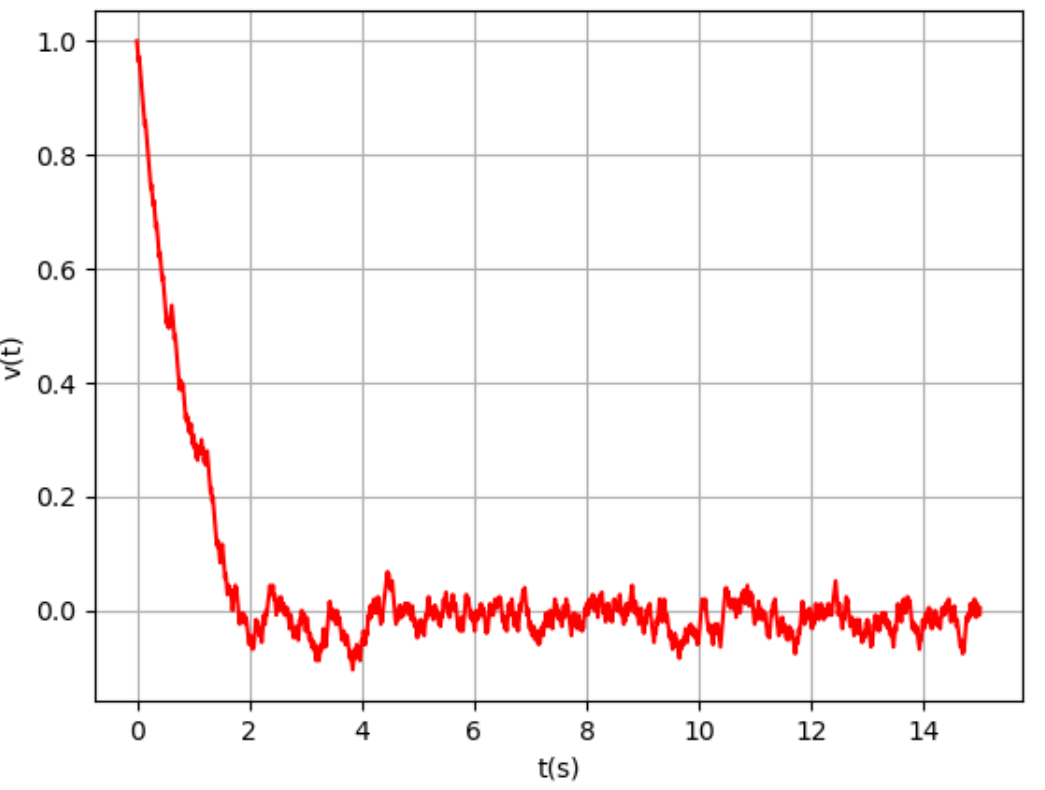
Figure 6. Resultant system output signal: sensor noisy case.